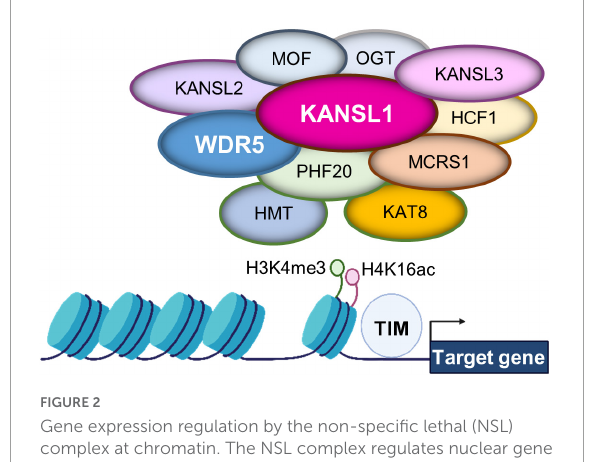
FIGURE2 Gene expression regulation by the non-specific lethal (NSL) complex at chromatin. The NSL complex regulates nuclear gene transcription by modifying histone H4 at lysine 16 (H4K16) and histone H3 at lysine 4 (H3K4). The complex contains multiple histone modifying enzymes and co-factors, including histone methyltransferase (HMT) and KAT8. Thus, the access of transcription factors is regulated for appropriate gene expression. These histone modifications are supported by KAT8 regulatory non-specific lethal (NSL) complex subunit 1 (KANSL1) and/or WD Repeat Domain 5